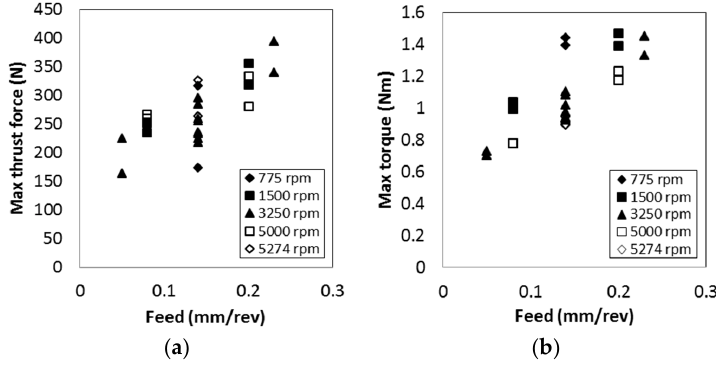
Figure 6. The effect of spindle speeds and feeds on maximum ( a ) thrust force and ( b ) torque.